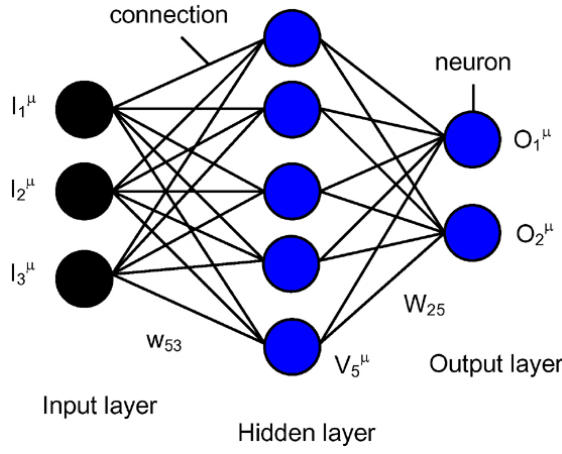
Fig. 2. A feed-forward neural network.